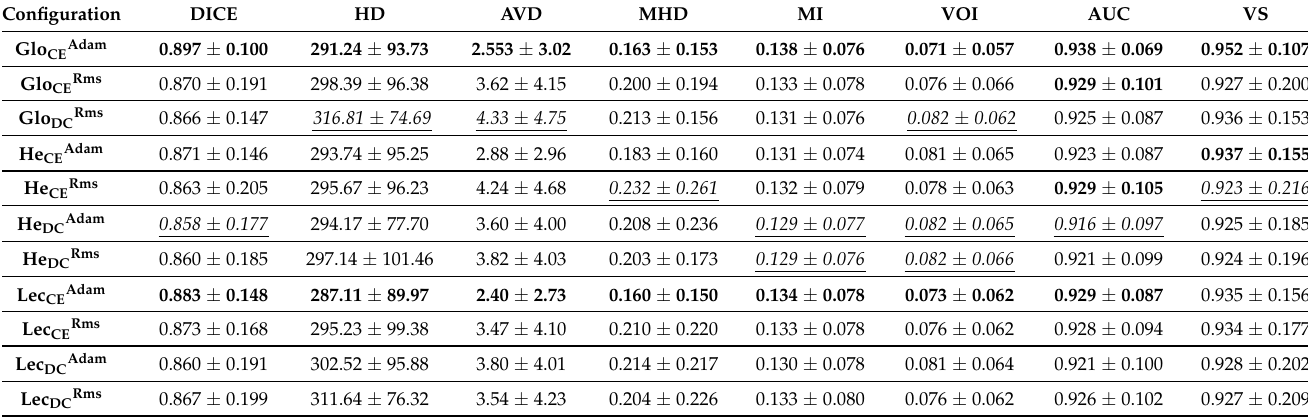
Figure 5. Axial and 3D view of prediction overlayed on ground truth segmentation of liver, Left Atrium and Pancreas ( 1a ) Liver segmentation result using Glo CEAdam (best dice), ( 1b ) Liver segmentation result using He DCAdam (lower dice), ( 2a ) Left Atrium segmentation result using He DCRms (best dice), ( 2b ) Left Atrium result using Lec DCAdam (lower dice), ( 3a ) Pancreas segmentation result using Lec CEAdam (best dice), ( 3b ) Pancreas segmentation using He CEAdam (lower dice). Table 1. Mean and standard deviation values for Segmentation metrics on Liver Database (higher values represented in bold and lower values in italics with